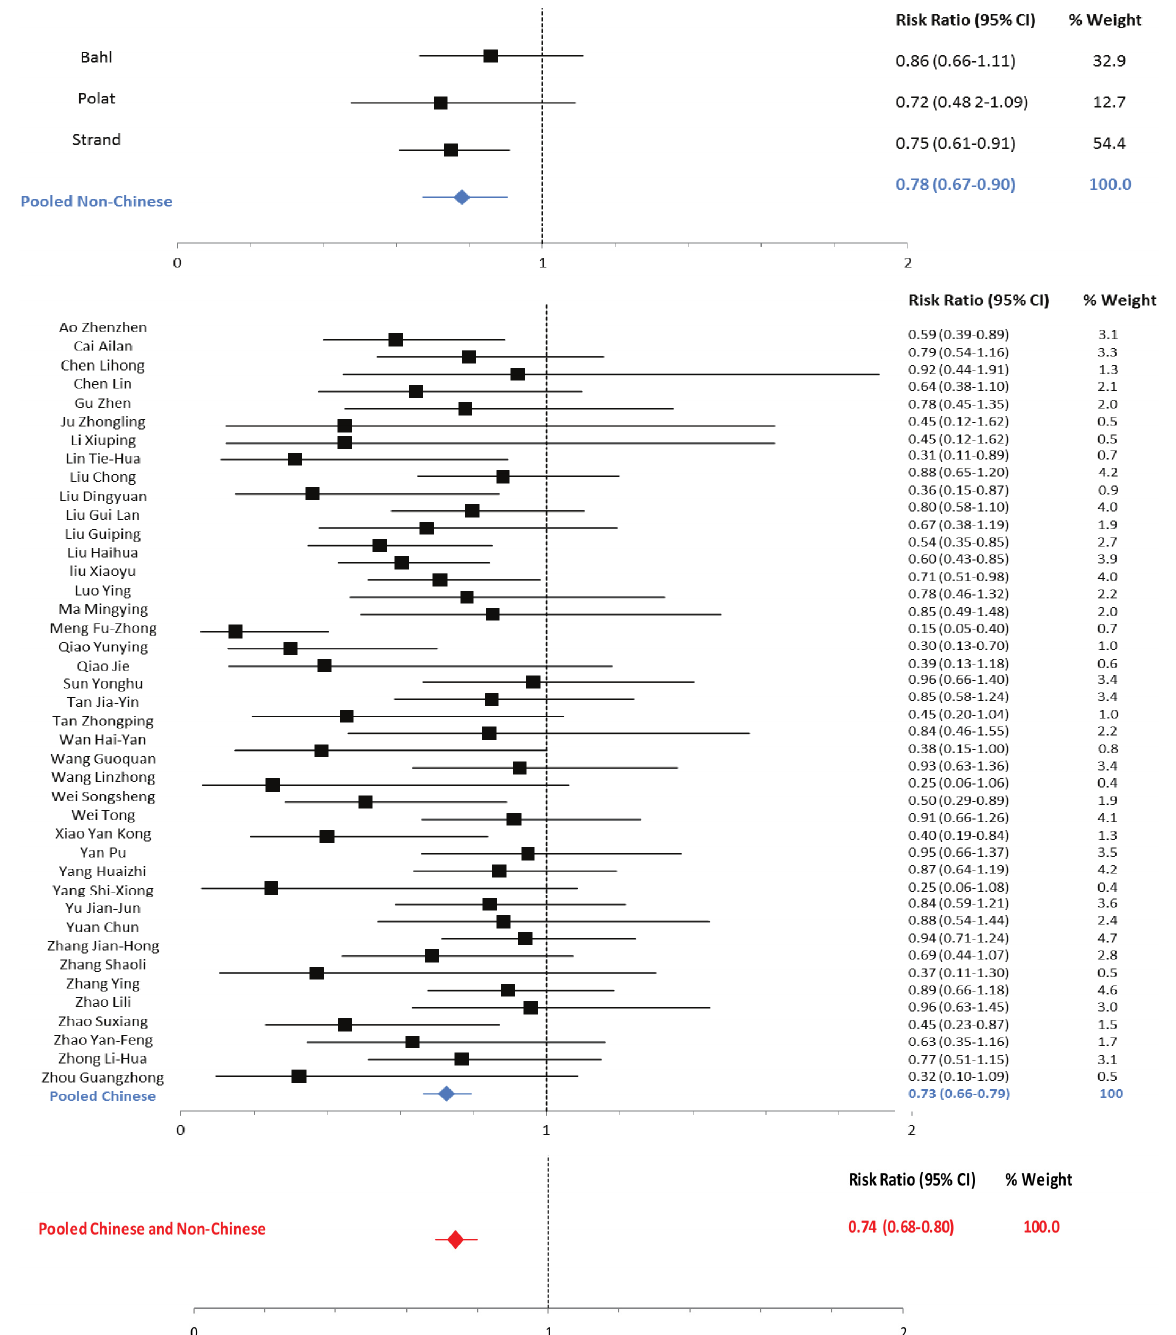
Figure 3. Forest plot for the effect of therapeutic zinc supplementation on non-specific diarrhea episodes lasting >3